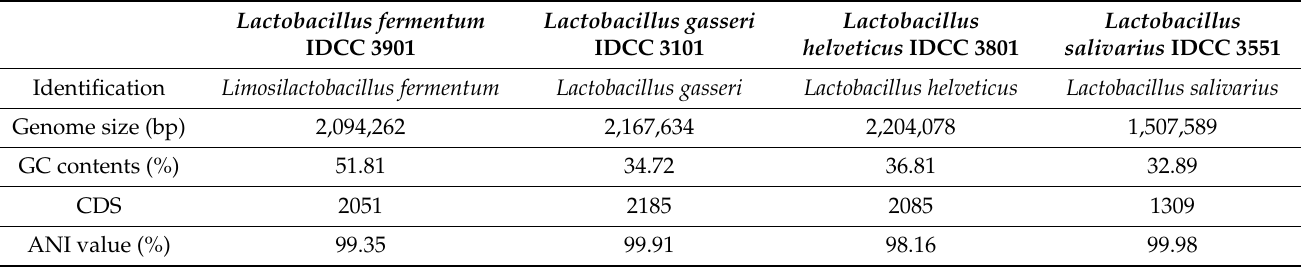
Table 3. Genomic information of four Lactobacillus species.